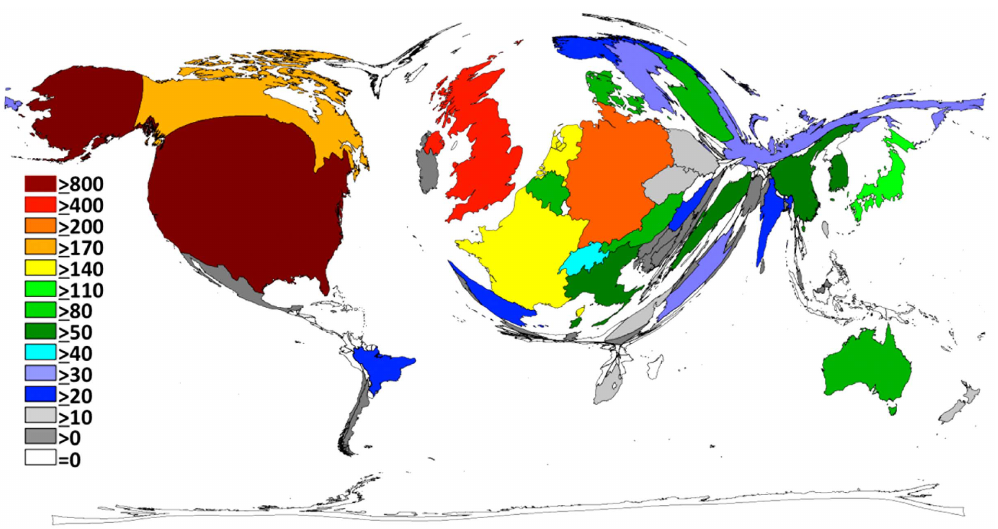
Figure 2. Global distribution of the number of published items.